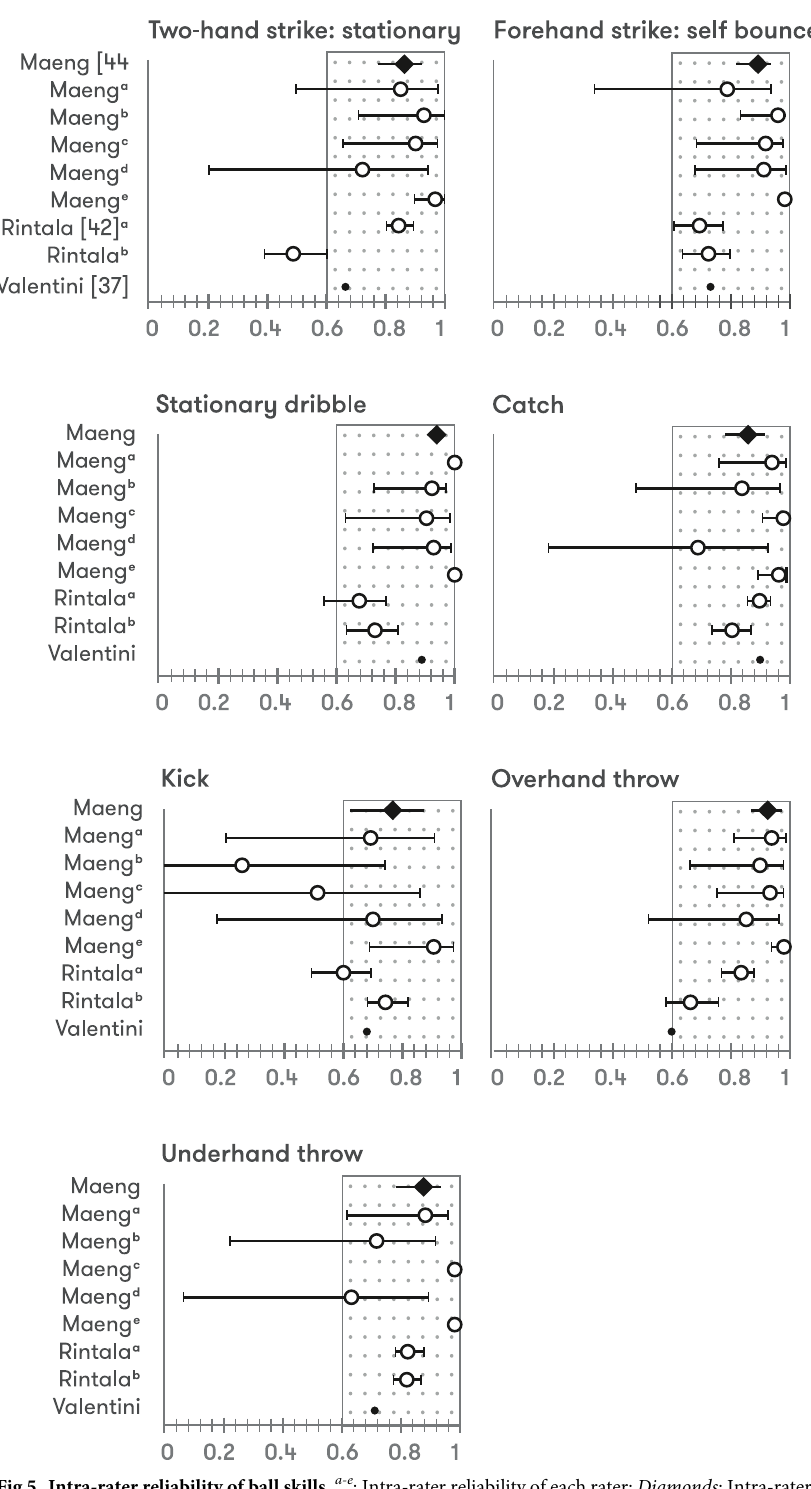
Fig 5. Intra-rater reliability of ball skills. a-e : Intra-rater reliability of each rater; Diamonds : Intra-rater reliability of all raters; Open circles : very good quality assessment according COSMIN checklist; Closed circles : adequate quality assessment according COSMIN checklist; Larger circles : ICC & 95%CI; Smaller circles : ICC.